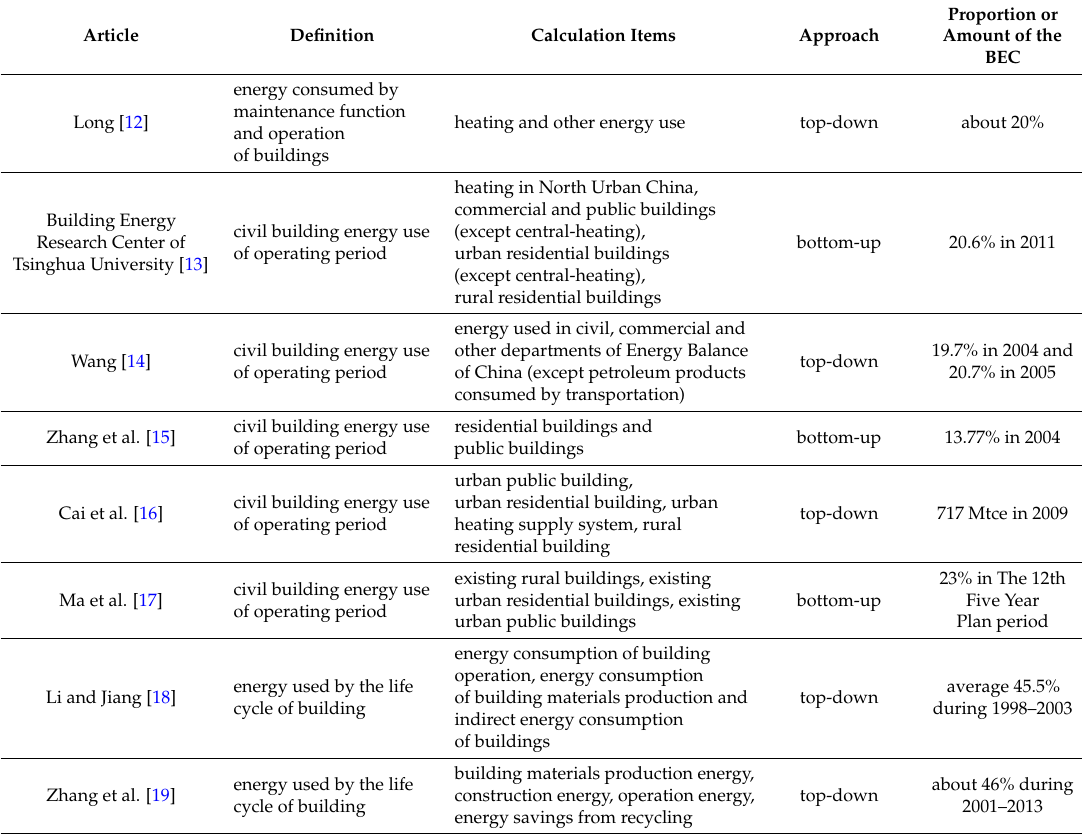
Table 1. Building energy consumption situation of different statistics in